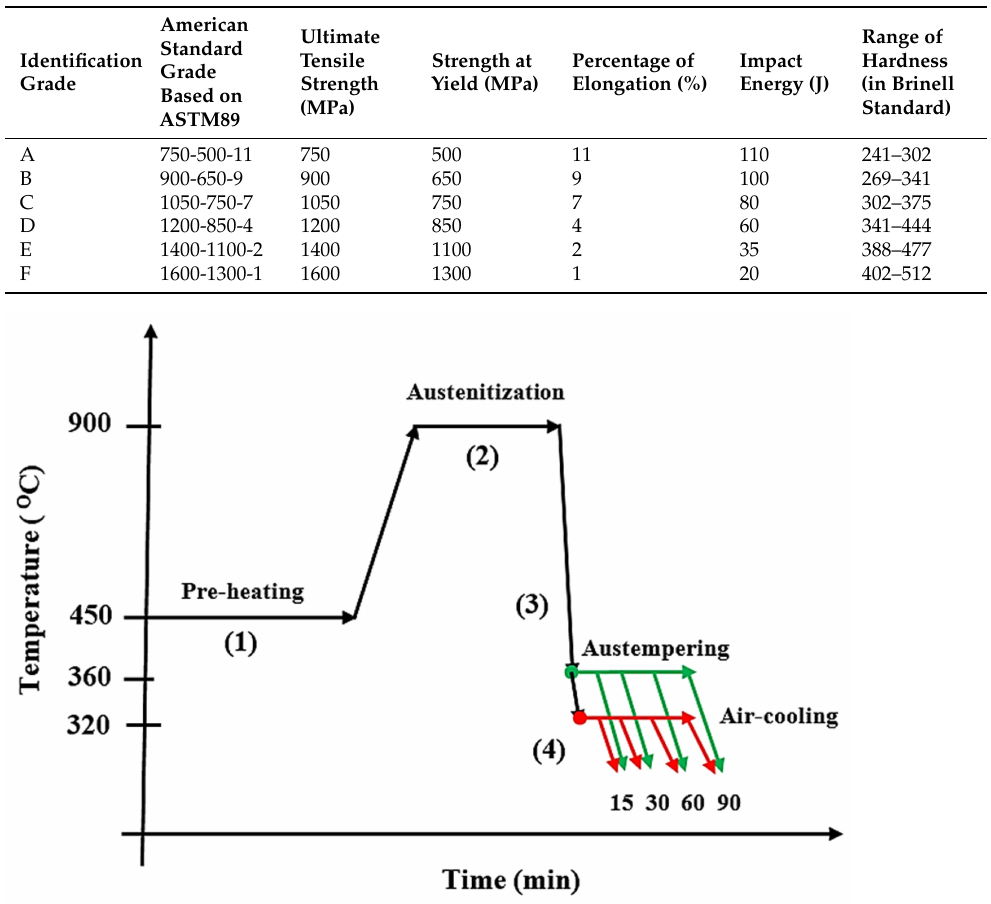
Figure 8. Graphical representation of the austempering heat treatment process of tested alloys